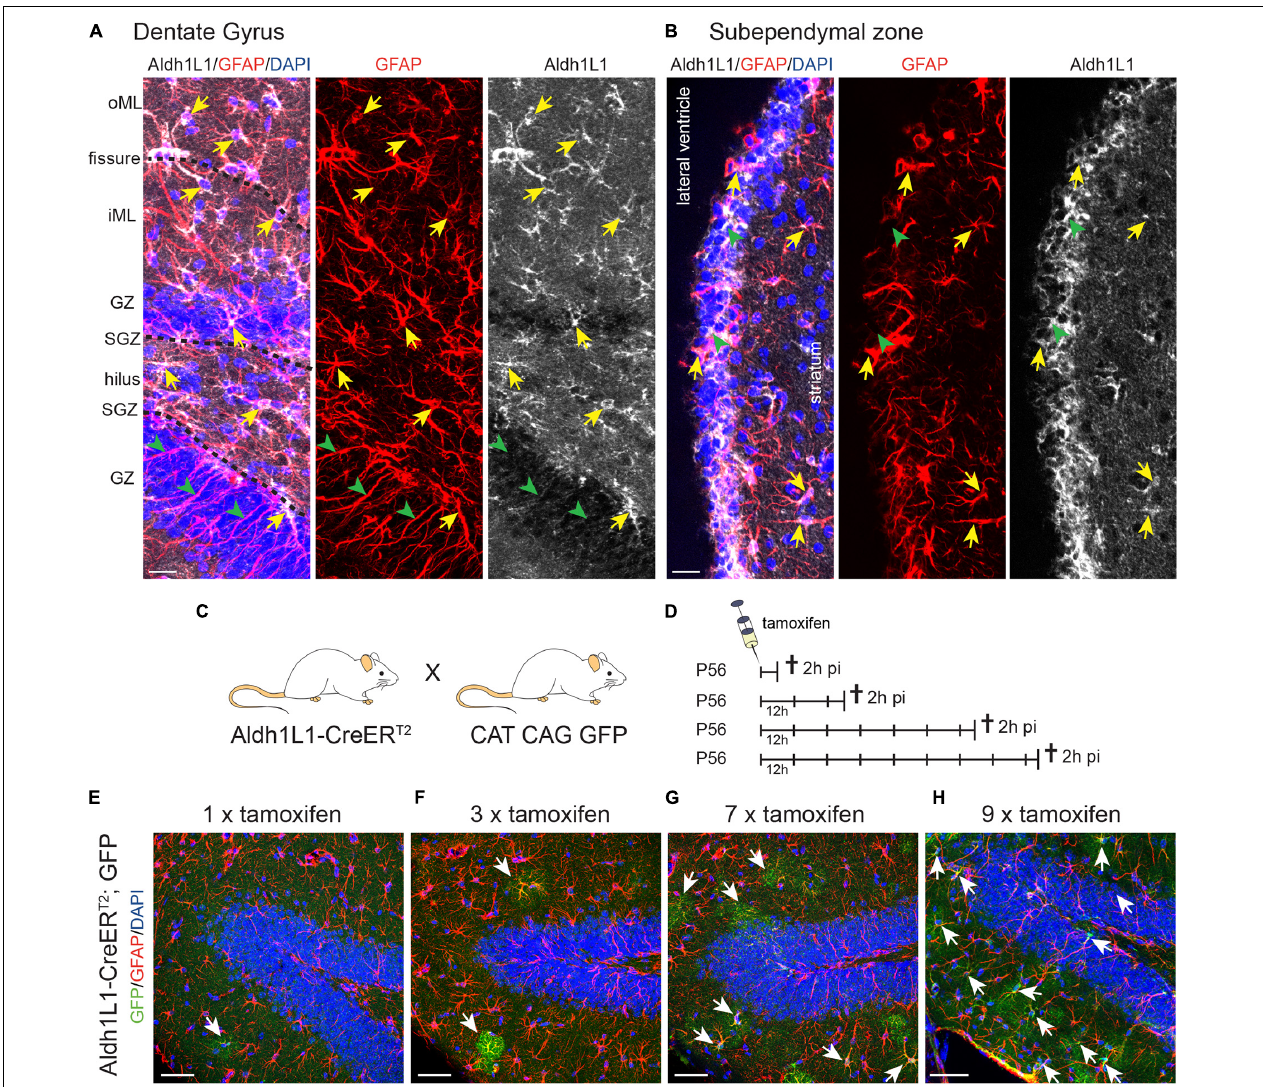
FIGURE 1 | Aldh1L1 expression in adult neurogenic niches. (A,B) Immunohistochemical co-staining of Aldh1L1 and GFAP in the adult mouse neurogenic niches (DAPI in blue, GFAP in red, Aldh1L1 in white). (A) Aldh1L1/GFAP double positive astrocytes reside in all DG layers (yellow arrows). Green arrowheads highlight GFAP-positive/Aldh1L1-negative radial processes of adult NSCs in the DG. DG compartment indicated on the left: oML, outer molecular layer; iML, inner molecular layer; GZ, granular zone; SGZ, subgranular zone; scale bar = 20 µ m. (B) Aldh1L1/GFAP double positive cells residing in the SEZ (yellow arrows). Green arrowheads point toward GFAP-negative/Aldh1L1-positive cells in the SEZ (scale bar = 20 µ m). (C) Crossing scheme showing the genotype of parental mice used to generate experimental Aldh1L1-CreER T2 ; GFP mice. (D) In order to achieve sufficient recombination, we used different tamoxifen pulses in Aldh1L1-CreER T2 ; GFP transgenic mice ranging from one to nine injections every 12 h (12 h) and analyzed recombination 2 h post-injection (2 h pi). (E–H) With increasing numbers of tamoxifen injections we observed an increase in the number of recombined astrocytes in the DG of adult Aldh1L1-CreER T2 ; GFP mice (DAPI in blue, GFP in green, GFAP in red; scale bar = 50 µ